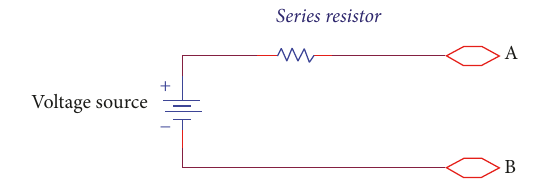
Figure 5: Characteristics of the L-filter.